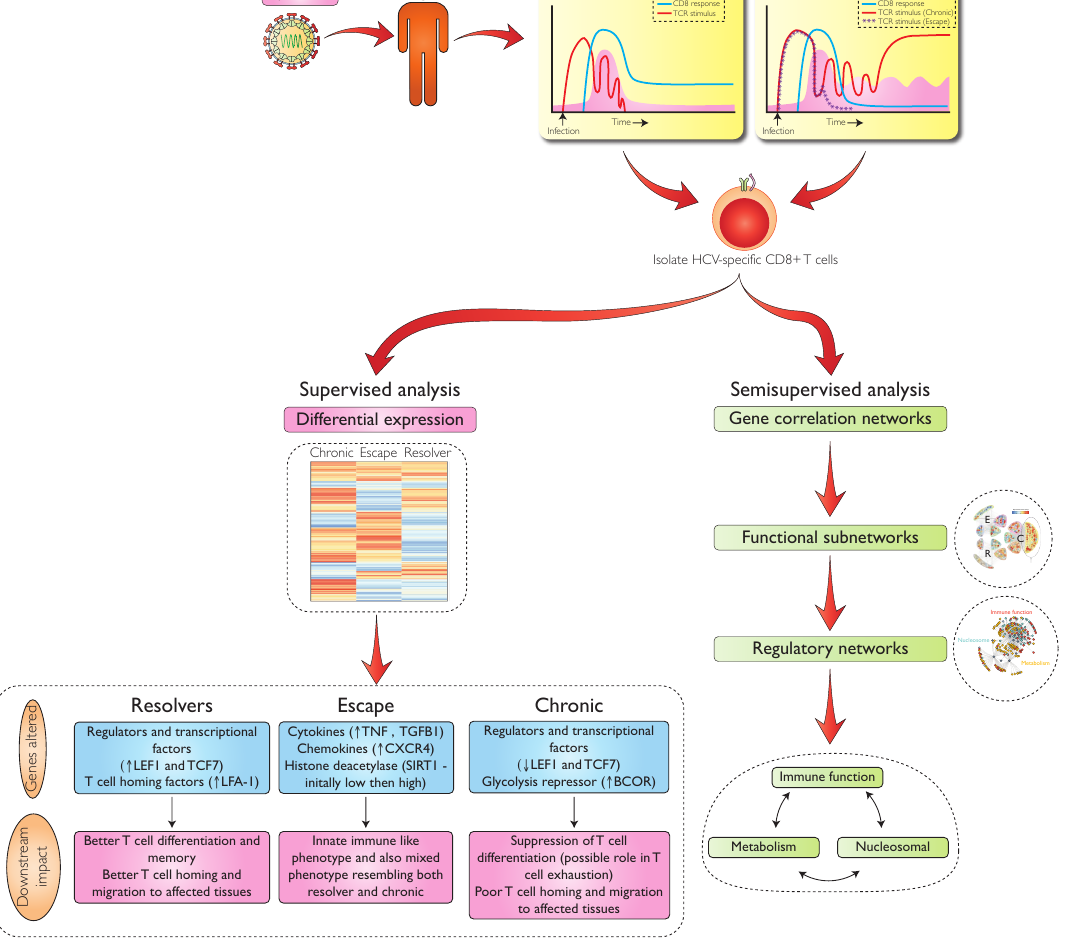
Figure 1. Flow diagram for the generation of transcriptional data from HCV-specific CD8 T cells in acute HCV infection followed by the di ff erent approaches to analysis of the data (as in Wolski et al., Immunity